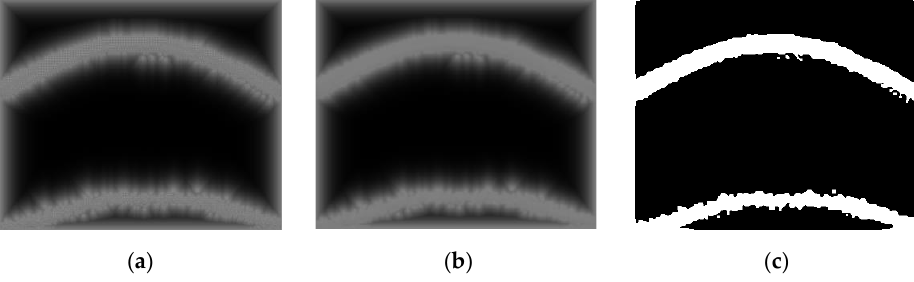
Figure 5. An example of the smoothing procedure on a fingertip image obtained from a smartphone video camera: ( a ) after distance transform; ( b ) after diffusion; and ( c ) after binarization.